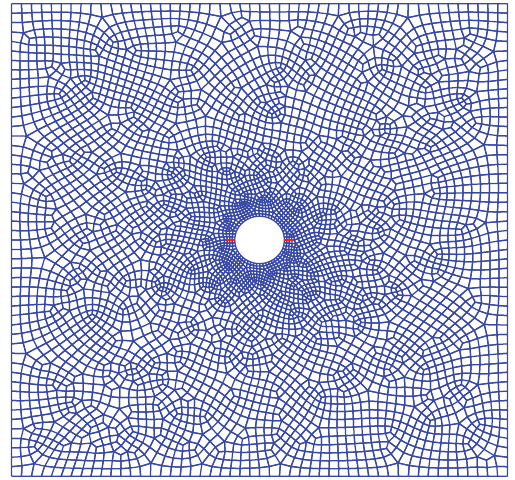
Figure 10: Discrete